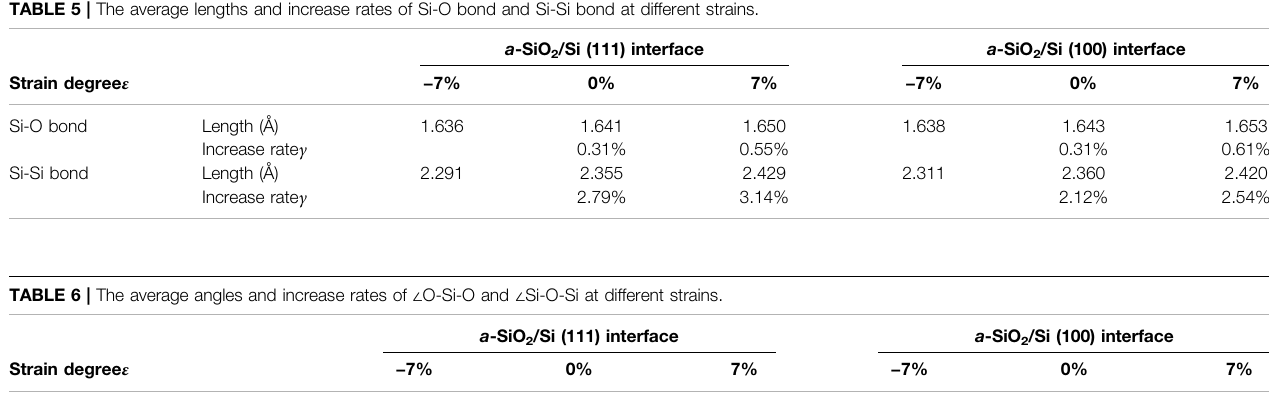
TABLE 5 | The average lengths and increase rates of Si-O bond and Si-Si bond at different strains.